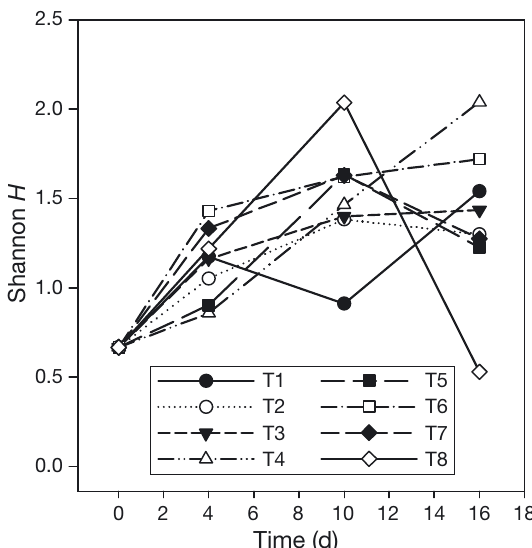
Fig. 5. Time development of the Shannon diversity index for the total micro-autotroph community for each nutrient load- ing treatment (T1−T8, see Table 1)